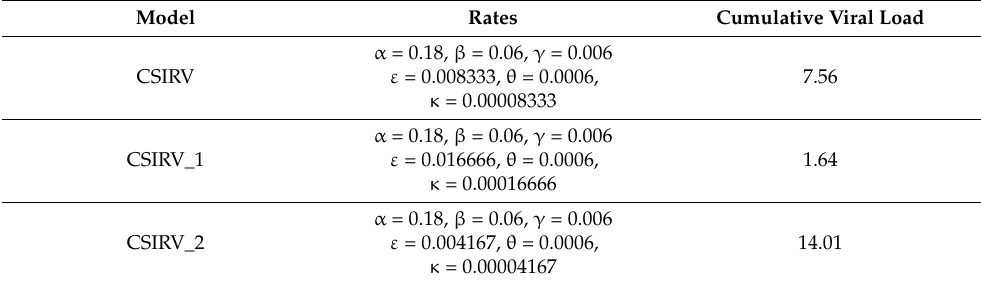
Table 2. Cumulative Viral load estimations for different scenarios of the CSIRV model (t = 365